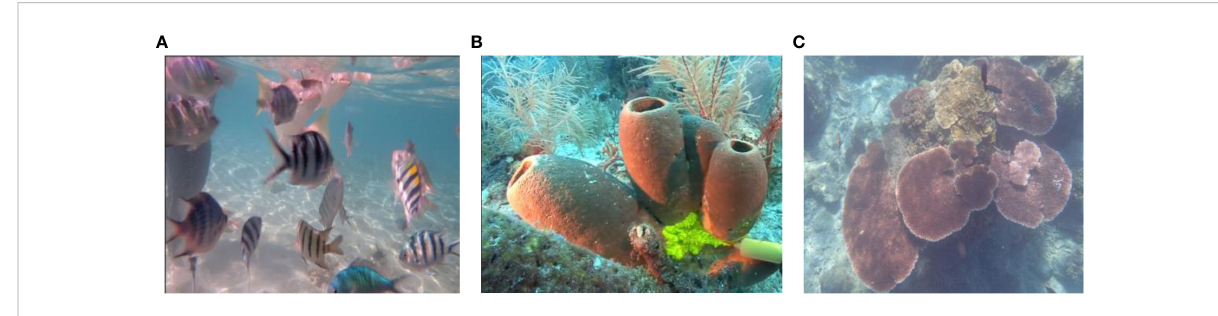
FIGURE 3 Some sample images of MUED database with a couple of